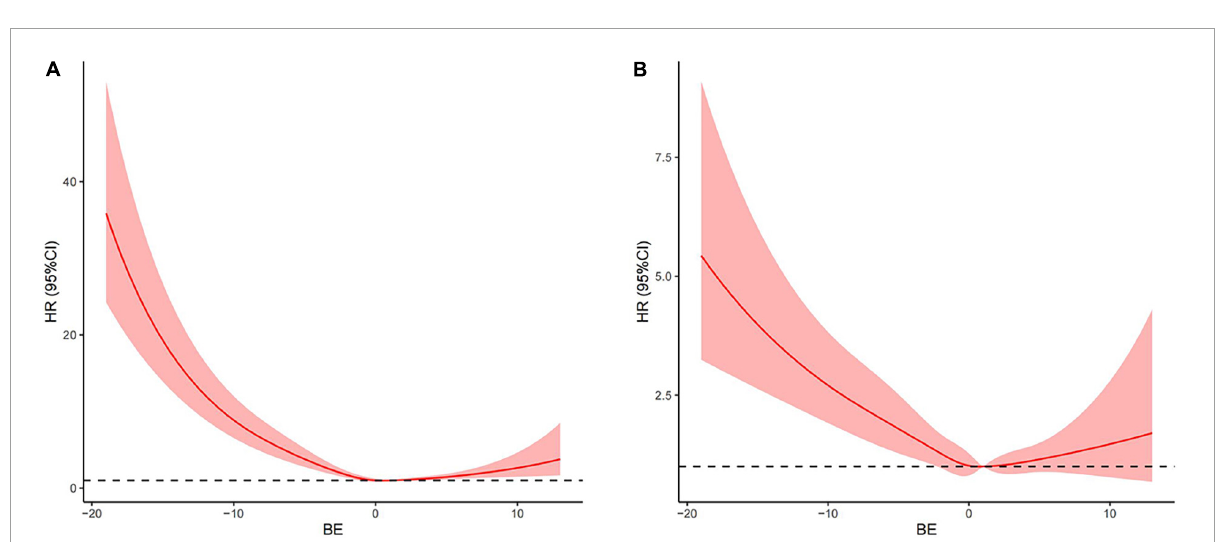
FIGURE2 Associations between base excess (BE) on a continuous scale and adjusted risk of 28-day all-cause mortality in patients with AMI. Crude hazard ratio (HR) and 95% CI for BE in 28-day mortality (A) . Adjusted HR and 95% CI for BE in 28-day mortality (B) . The analyses used a model with restricted cubic splines. Adjusted variables included age, gender, systolic blood pressure (SBP), diastolic blood pressure (DBP), hypertension, atrial fibrillation (AF), chronic obstructive pulmonary disease (COPD), acute kidney injury (AKI), sepsis, congestive heart failure (CHF)